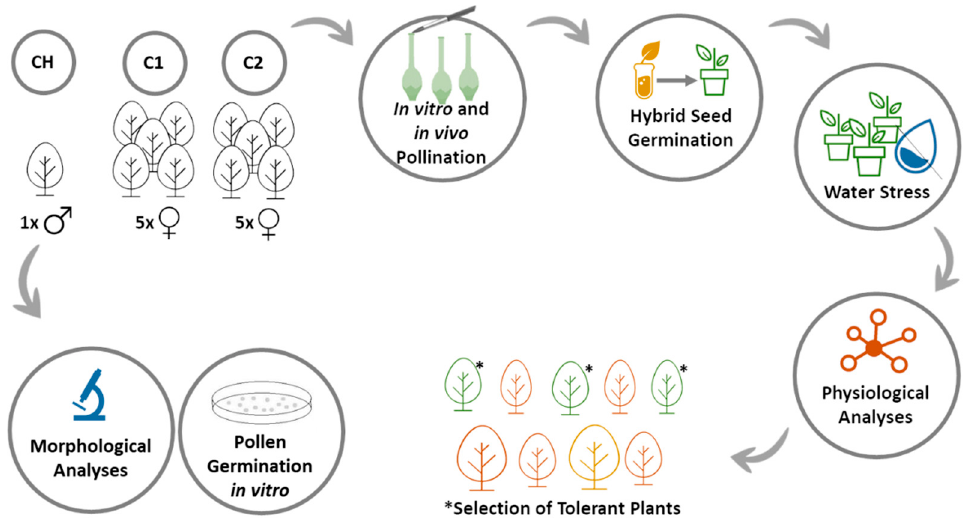
Figure 1. Methodology scheme applied in this work to study the phenology and reproductive anatomy of strawberry tree as well as selection of drought tolerant plants.